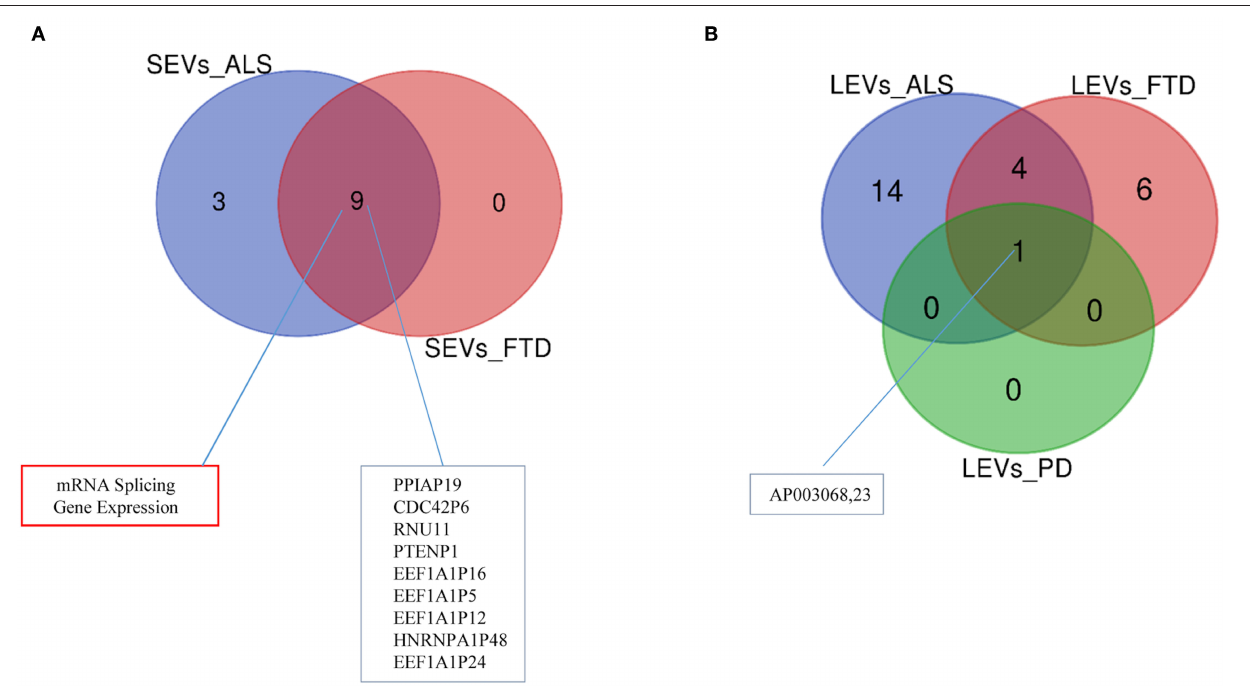
FIGURE 6 | Venn diagram showing numbers of common and unique lncRNAs and pseudogenes in SEVs from plasma of patients with ALS and FTD (A) and in LEVs (B) from plasma of ALS, FTD, and PD. Common lncRNAs and pathways are listed. Differential mRNA expression analysis was carried out using DESeq2 (log2FC > 1, p <